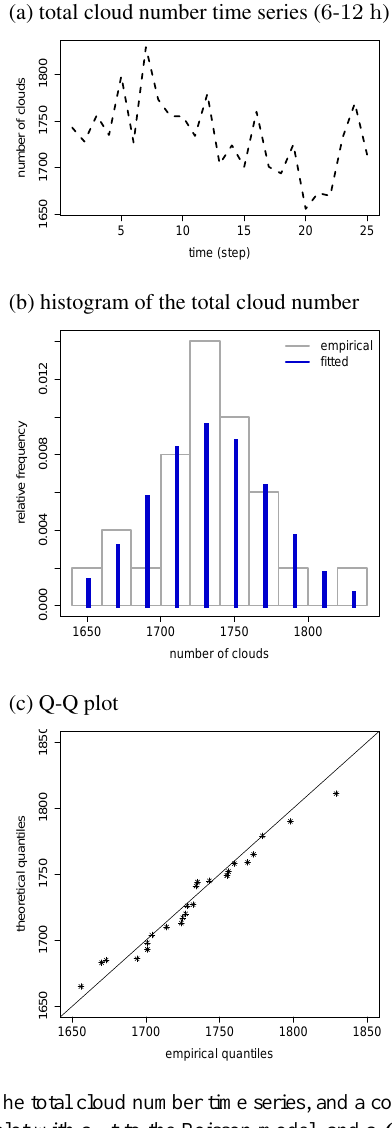
Figure 7. The total cloud number time series, and a corresponding histogram plot with a fit to the Poisson model, and a Q – Q plot as a goodness of fit test. The distribution is fitted using the method of moments, while the histograms and Q – Q plots are made using R libraries (R Core Team, 2013). The time interval between the snap- shots is